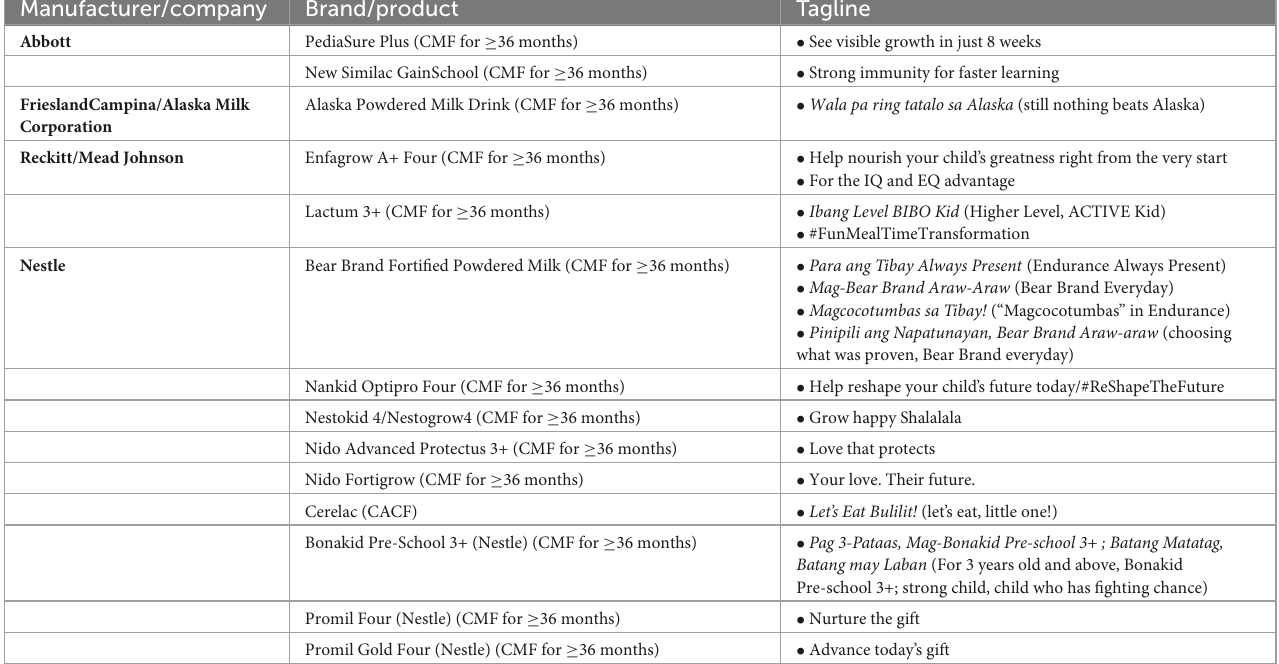
TABLE 4 List of products and taglines in promotional materials captured in media